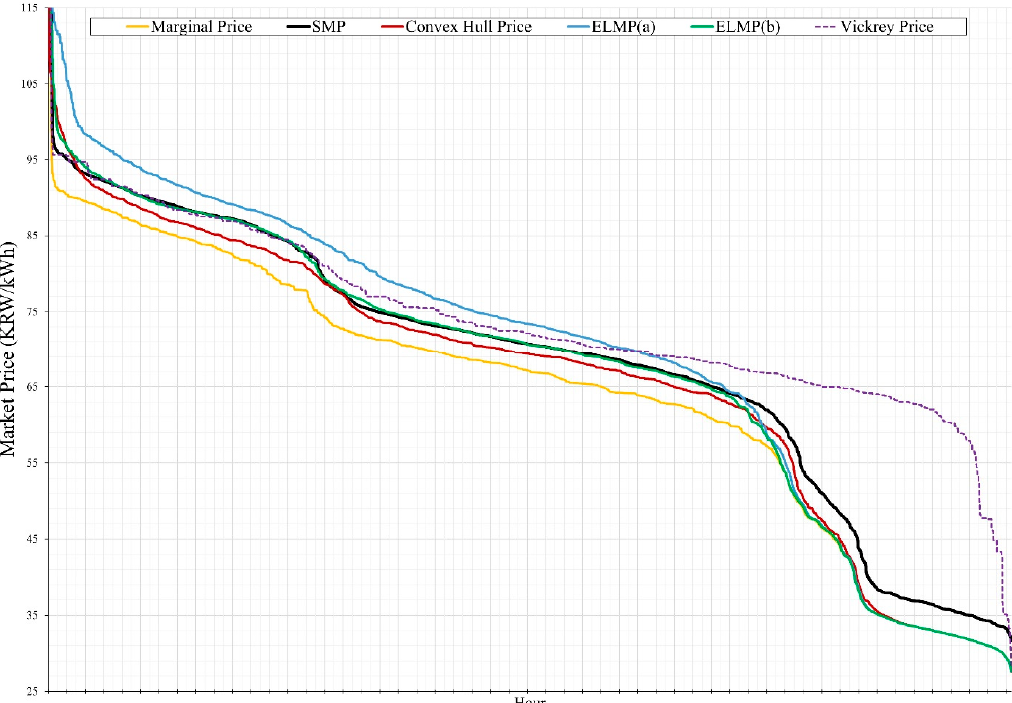
Figure 5. Price duration curves by market price for 2016.